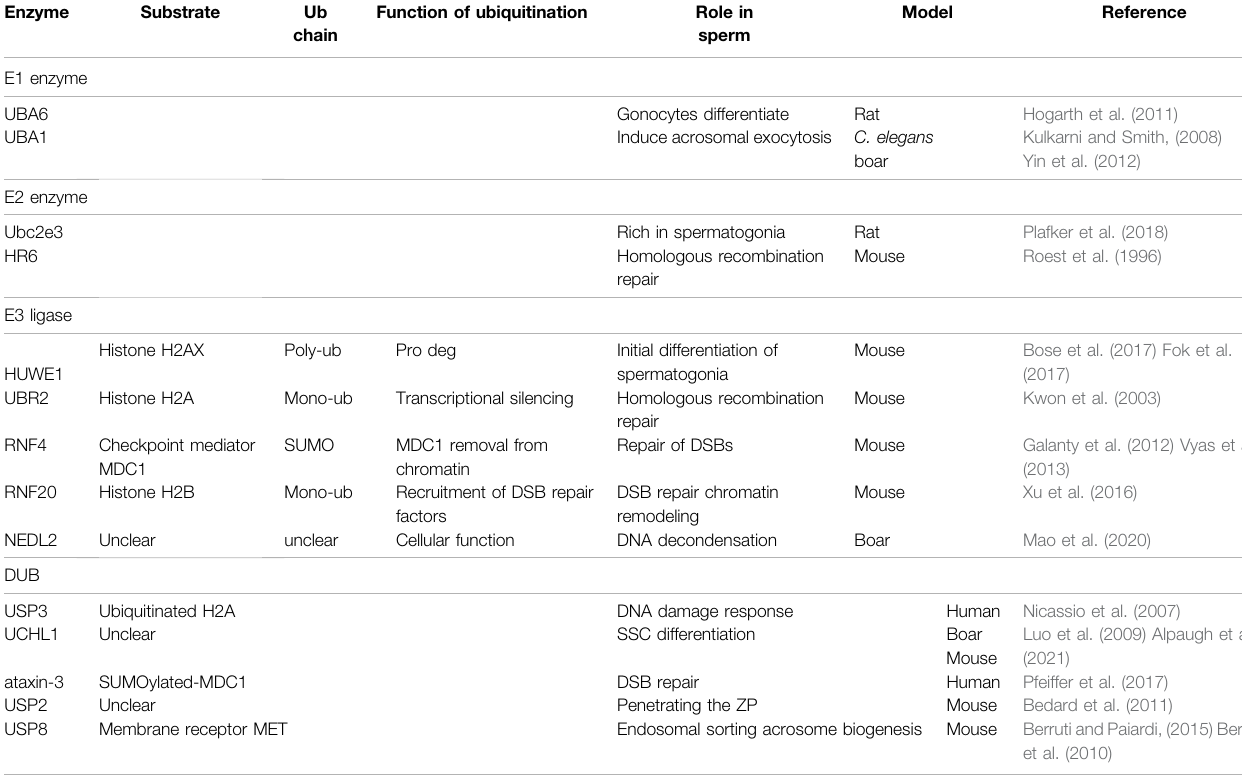
TABLE 1 | Ubiquitination and deubiquitination machinery and targeted substrates work to regulate sperm development and function.